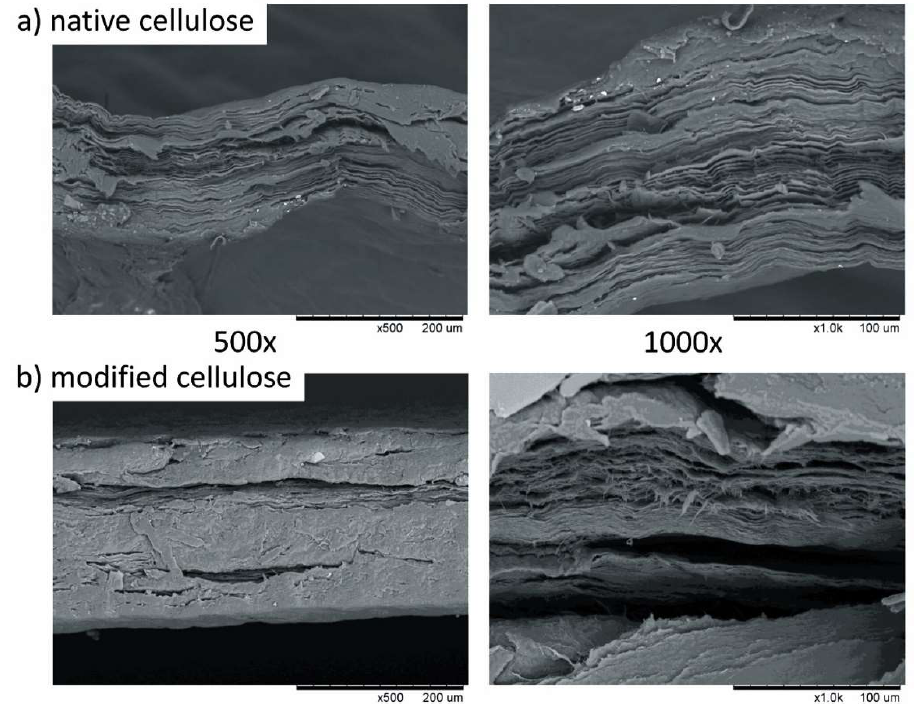
Figure 2. Cross-section structure of bacterial cellulose (500× and 1000× magnification): ( a ) native cellulose and ( b ) modified cellulose. cellulose and ( b ) modified